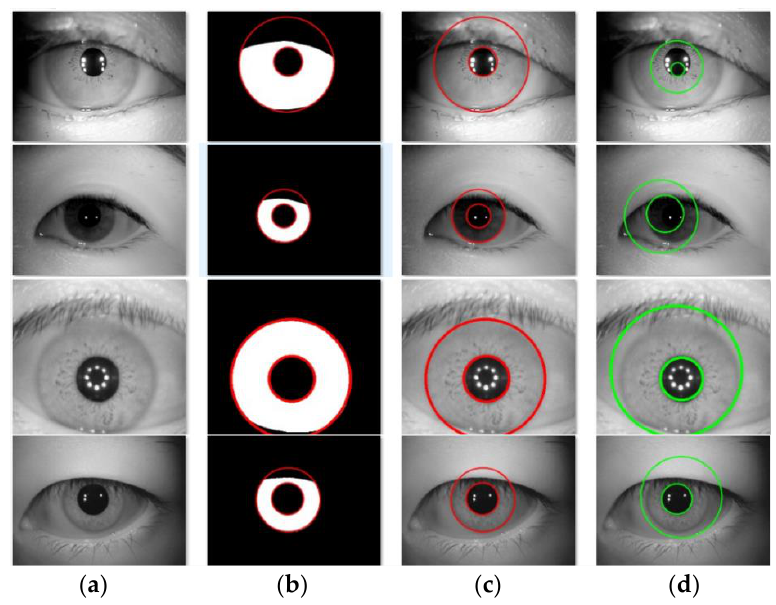
Figure 13. Positioning results comparison of PFSegIris and OSIRIS V4.1 on four iris test sets: ( a ) original images; ( b ) mask positioning images; ( c ) PFSegIris positioning images; ( d ) OSIRIS V4.1 positioning images.